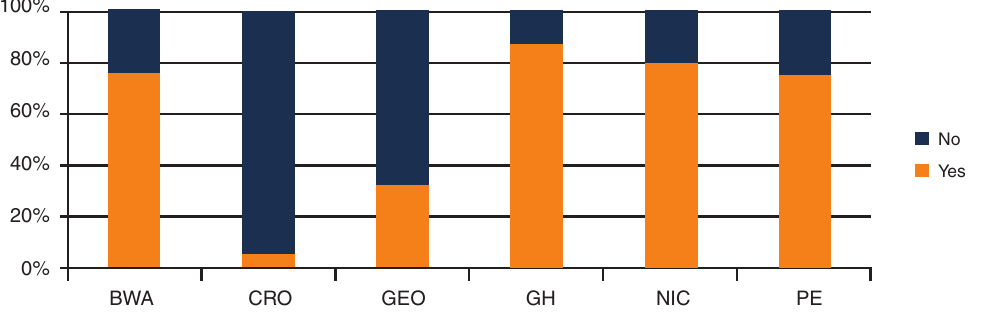
FIGURE A9.5. Distribution of “Simulated Self-Referred Patient” Visits That Ended with Dispensation of an Antimicrobial, by